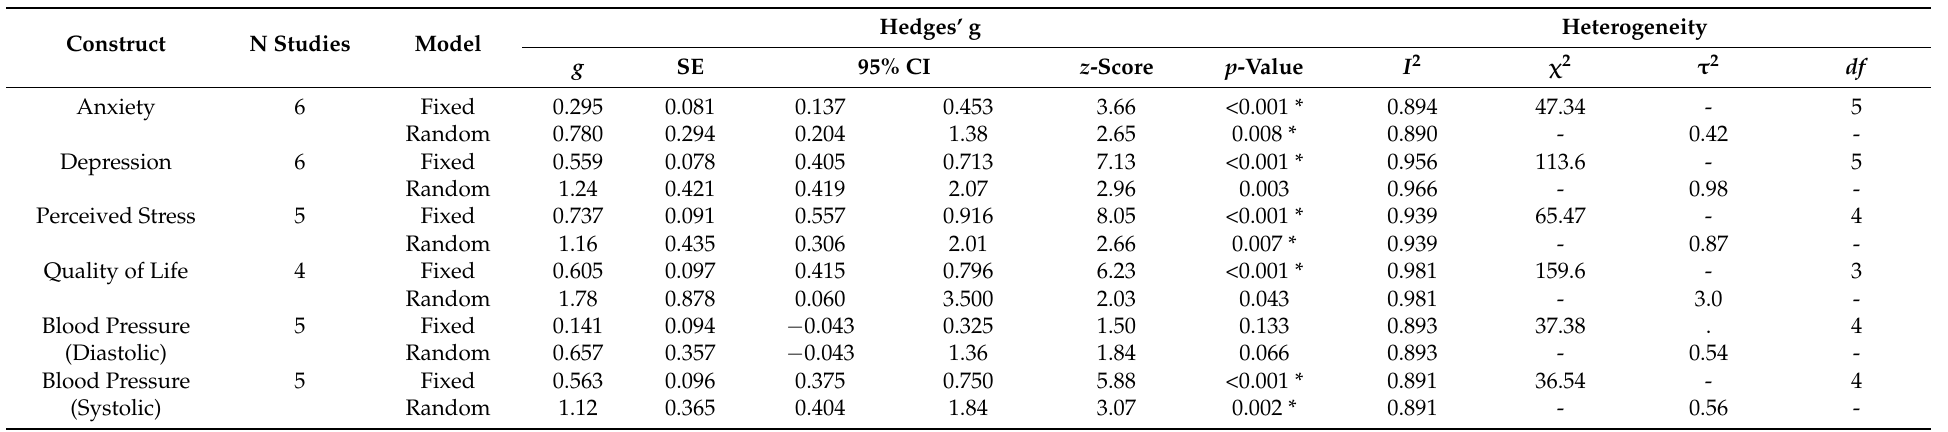
Table 4. Summary of meta-analysis results—fixed and random-effects